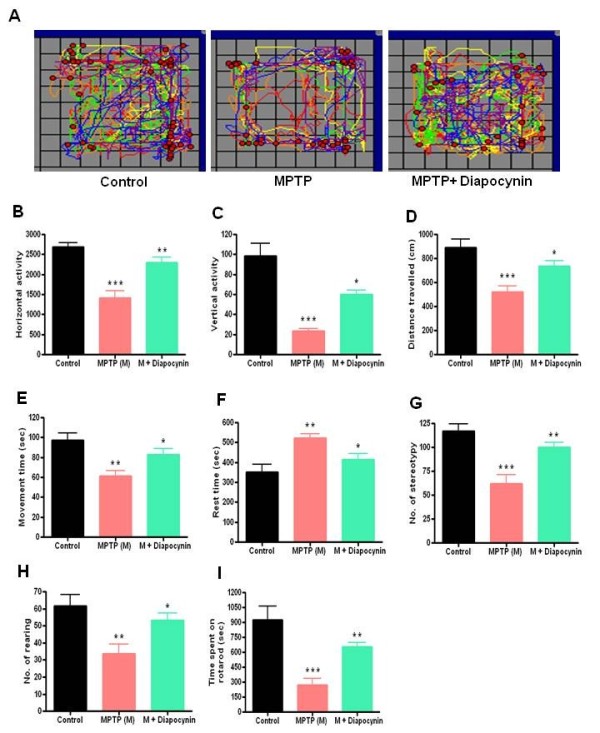
Diapocynin improves motor function in the MPTP-injected mice. (A) VersaPlot map showing moving track of mice. VersaMax data showing (B) horizontal activity, (C) vertical activity, (D) distance travelled (cm); (E) movement time (sec); (F) rest time (sec), (G) number of stereotypies, (H) number of rearings and (I) time spent on rotarod (sec) at rod speed 20 rpm. Data are means ± SEM of 8 to 10 mice per group. ***P <0.001 vs the control group; **P <0.01 vs the MPTP group; *P <0.05 vs the MPTP group; #P <0.01 vs the control group.